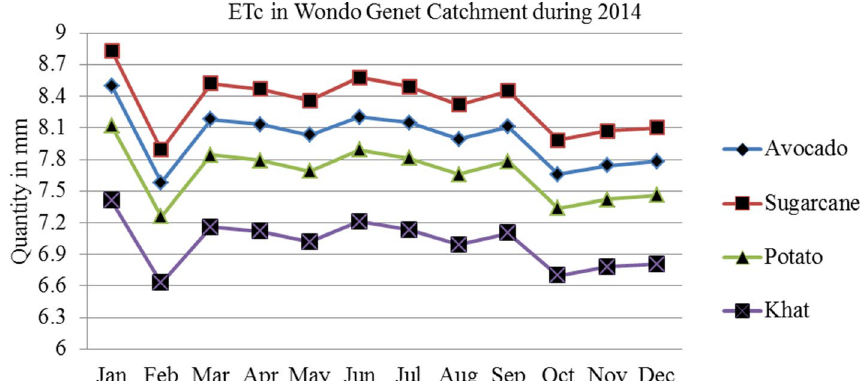
Fig. 6 Average daily crop evapotranspiration of main field crops and fruit in Cheleleka watershed,